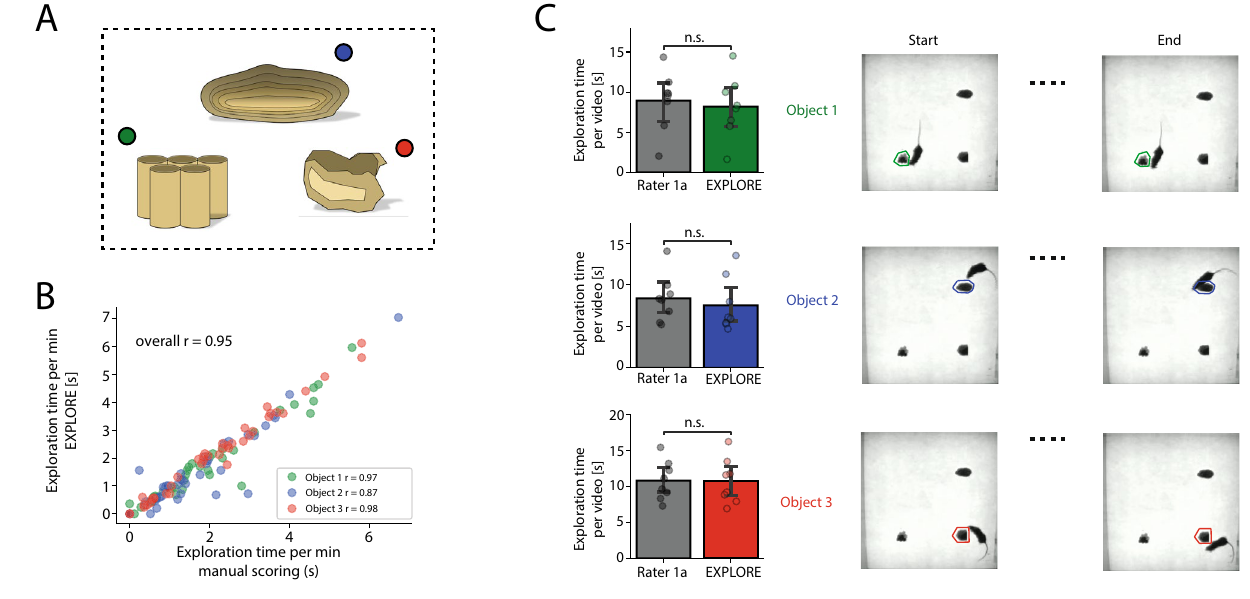
Figure 3. The performance of EXPLORE on multiple objects. ( A ) Results are shown for an experiment with 3 objects to explore in the experimental arena. ( B ) Scatterplot showing how the results of EXPLORE calculating the object exploration time correlates to the human rater level for all objects. ( C ) For each object, the exploration time per video measured by EXPLORE was compared to the manually scored exploration time. We found no statistically significant difference between EXPLORE and the human rater (paired Wilcoxon test, the significance level was set to p ≥ 0.05 as non significant (n.s.)).